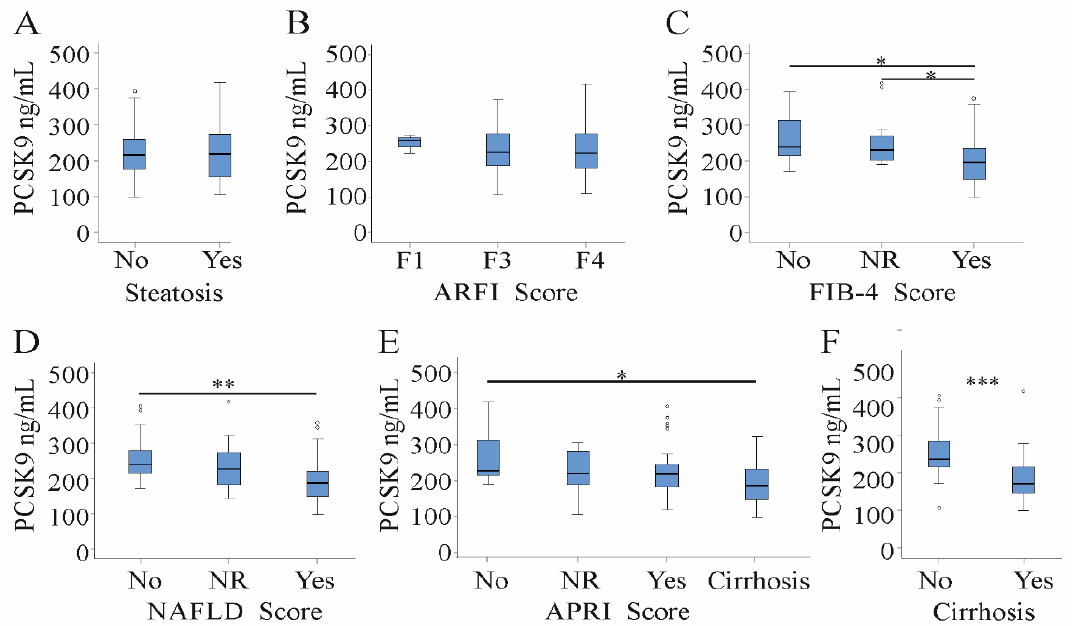
Figure 2. Serum PCSK9 in patients with chronic HCV stratified for steatosis, fibrosis scores and cirrhosis. ( A ) PCSK9 in serum of 37 patients with and 45 patients without liver steatosis; serum PCSK9 levels in patients stratified for fibrosis by ( B ) the acoustic radiation force impulse (ARFI) score; ( C ) the fibrosis-4 (FIB-4) score; ( D ) the non-alcoholic fatty liver disease (NAFLD) score and ( E ) the aminotransferase/platelet ratio index (APRI) score (no fibrosis = no; not reliable values = NR, fibrosis = yes); ( F ) serum PCSK9 in 37 patients with liver cirrhosis and 45 non-cirrhotic patients assessed by ultrasound. Small circles above or below the boxes mark outliers. * p < 0.05, ** p < 0.01, *** p < 0.001. HCV patients with liver cirrhosis indeed had PCSK9 serum levels (171 (99–418)